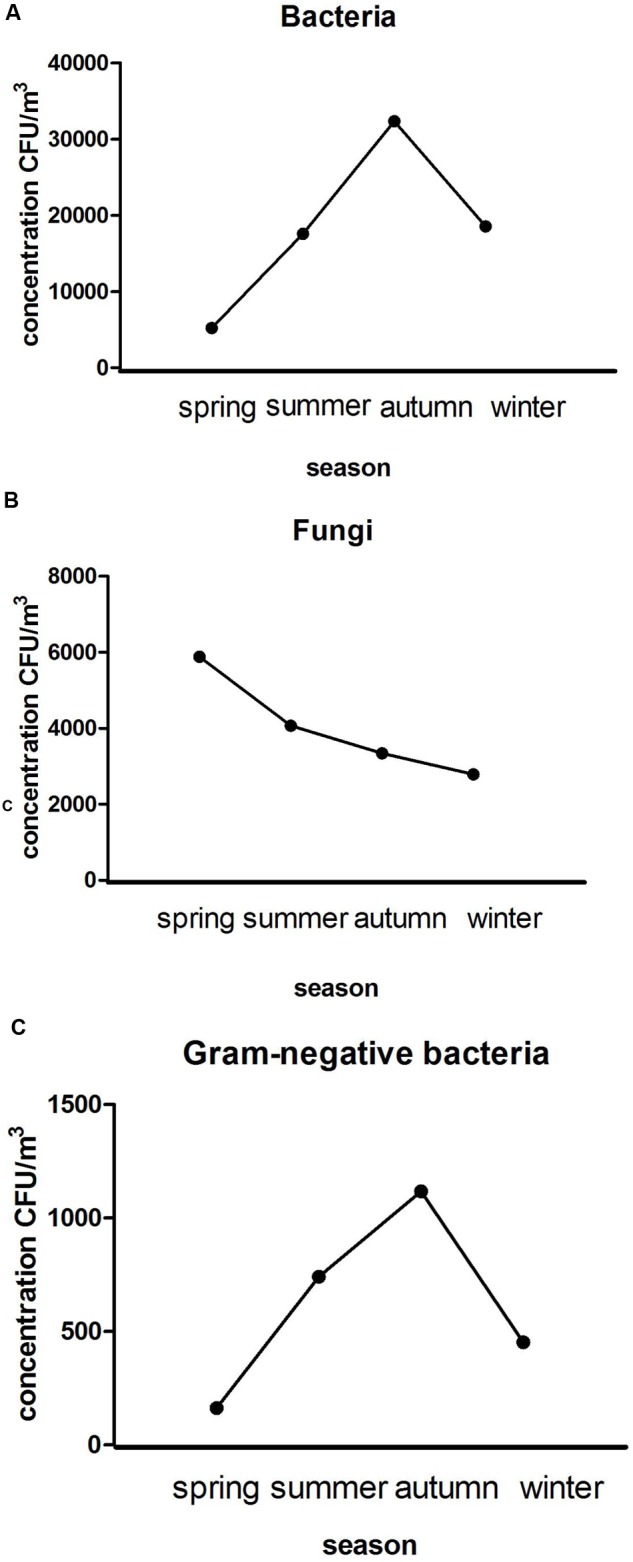
Average seasonal concentration variations of bacteria (A), fungi (B), and Gram-negative bacteria (C).